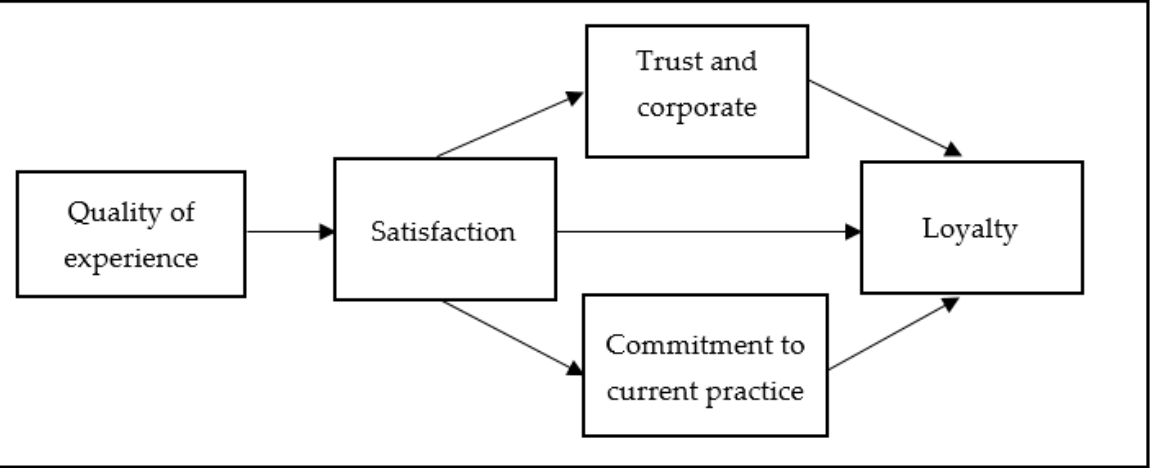
Figure 9. Satisfaction model to explain the use of innovations. Based on Johnson et al.